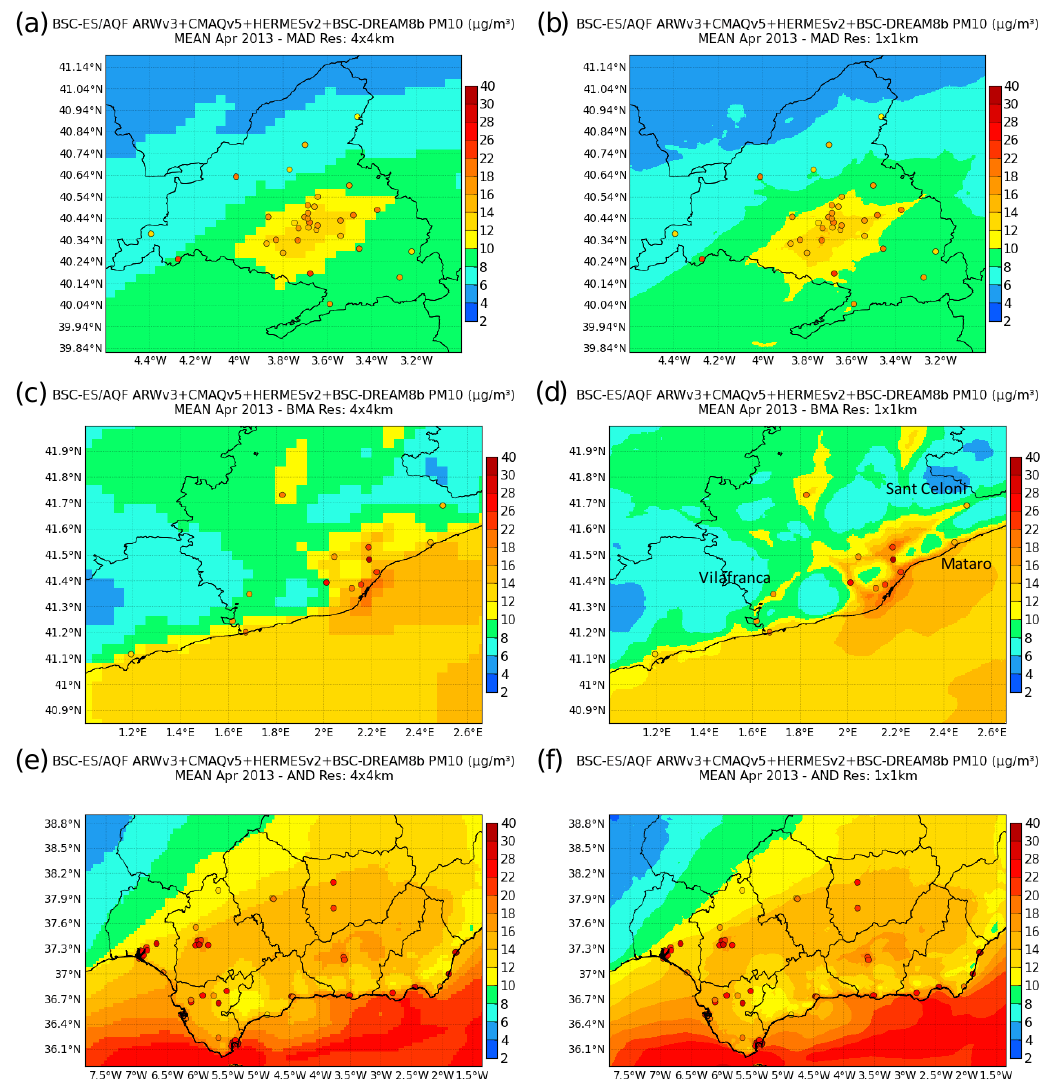
Figure 5. CALIOPE-AQFS mean PM 10 concentrations (µgm − 3 ) in April 2013 over (a, b) MAD, (c, d) BCN, and (e, f) AND, as a function of horizontal resolution: 4km (left column) and 1km (right column). Dots indicate the mean concentrations at the air quality